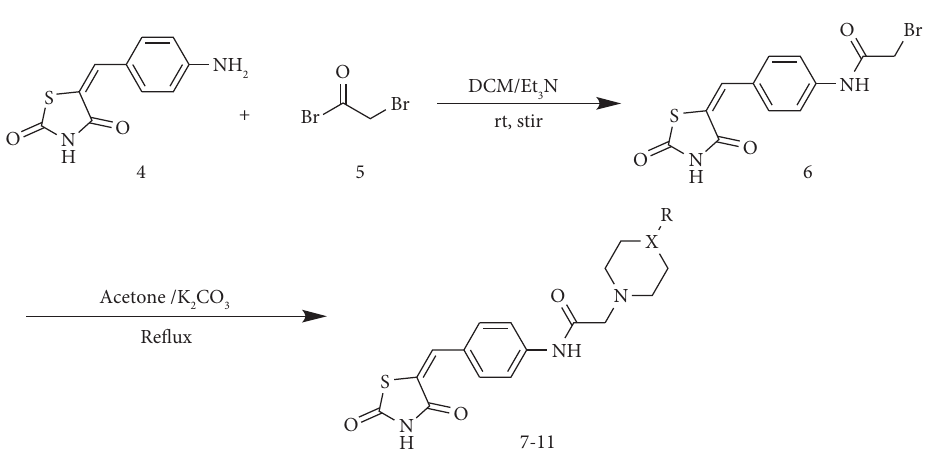
Scheme 2: Synthesis of targeted compounds C1–C5.